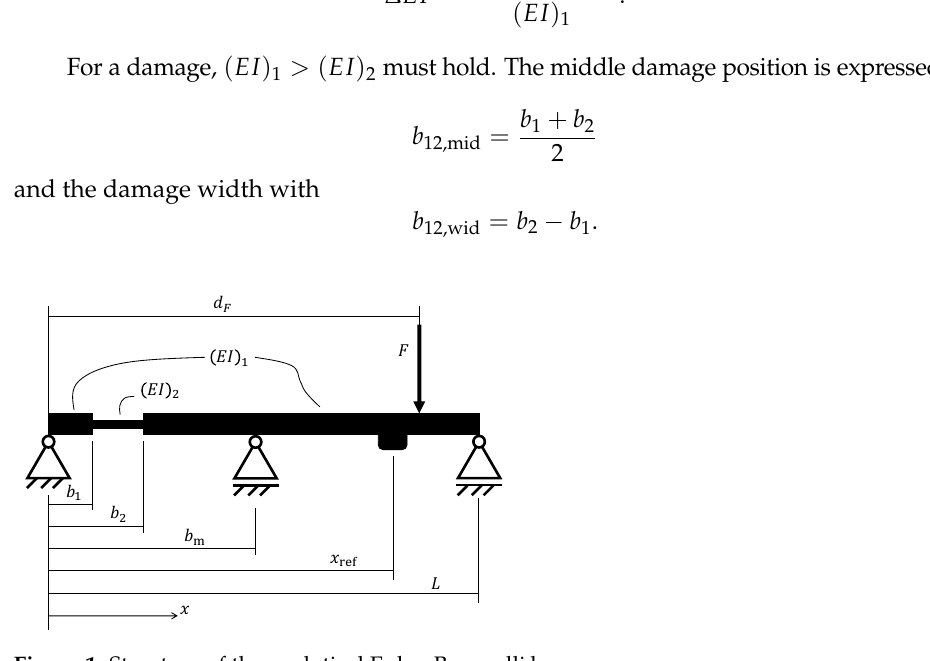
Figure 1. Structure of the analytical Euler–Bernoulli